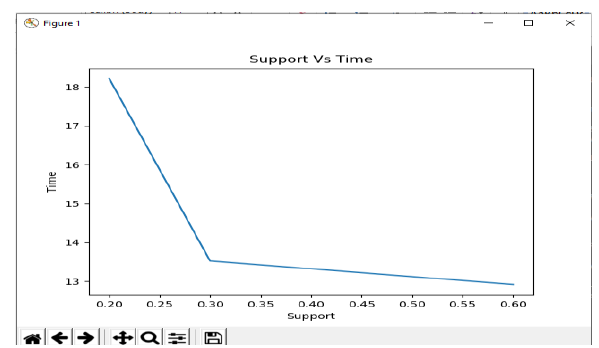
Fig 4:- Apriori Of Instacart Dataset